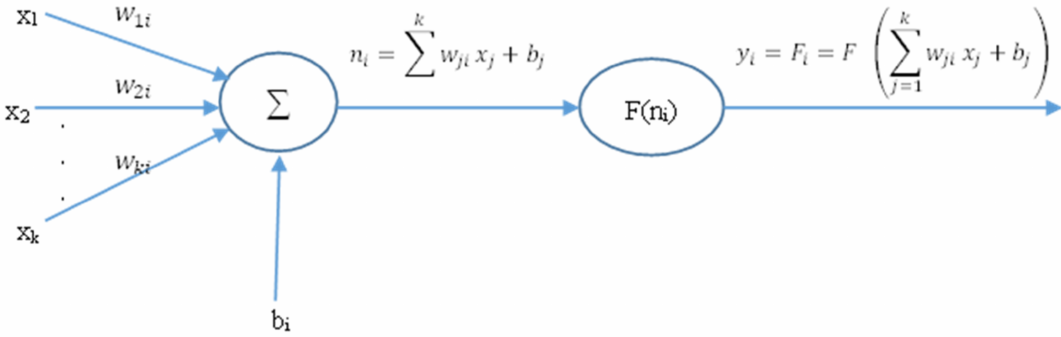
Figure 11. Schematic of a simple MLP